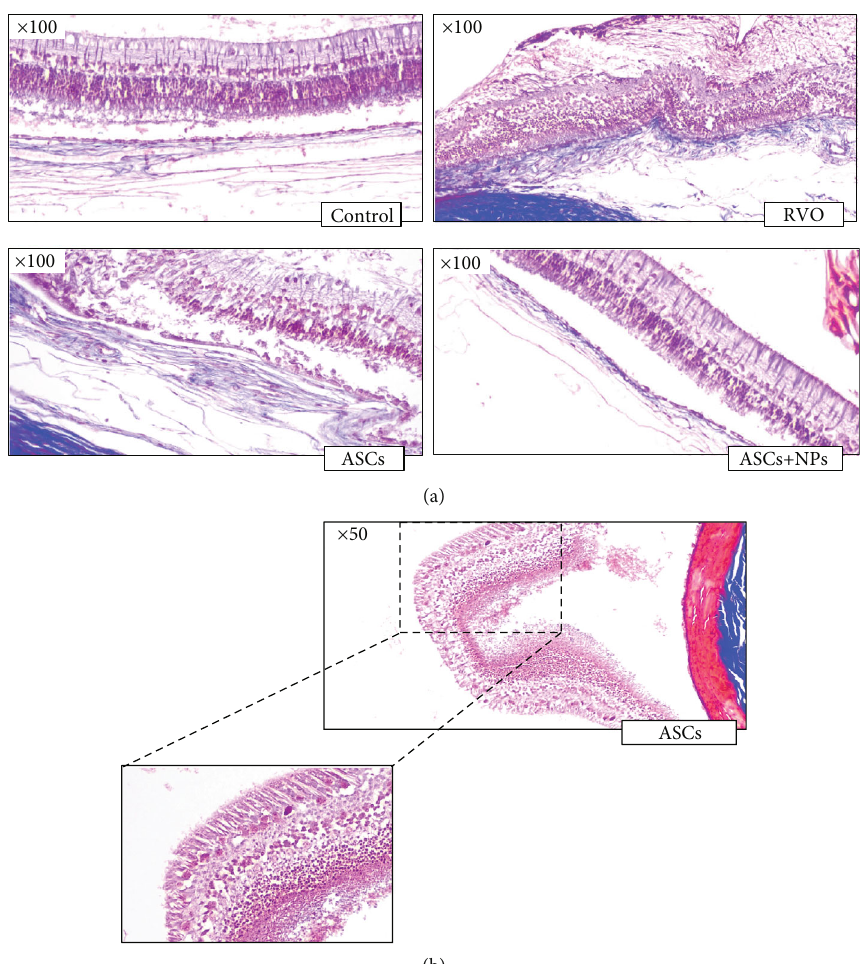
Figure 7: Masson trichrome stain. (a) Retina total degeneration and disorganized chorioretinal adhesion in the RVO group vs. the ASC groups where limited detachment is observed. (b) Müller and microglial cell migration to ASC intravitreal injection site leads to retina fold